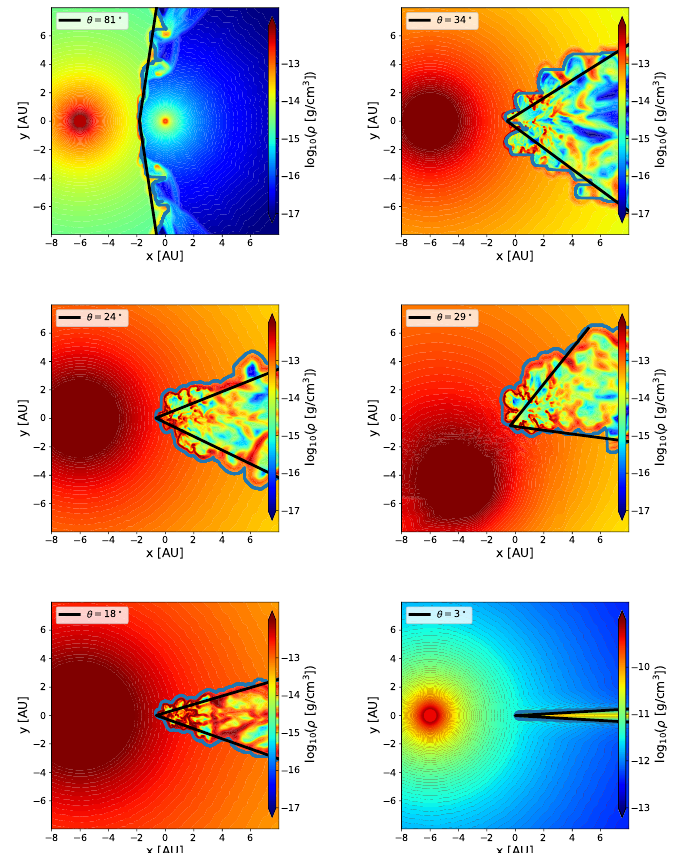
Figure 8. A fit to the colliding wind structure semi-opening angle. The blue line is the result of the wind shape detection algorithm and the black line is the optimal line of an asymptotic opening. Upper left: Run 1. Upper right: Run 2. Middle left: Run 3. Middle right: Run 4. Lower left: Run 5. Lower right: Run 6 (note the different colour